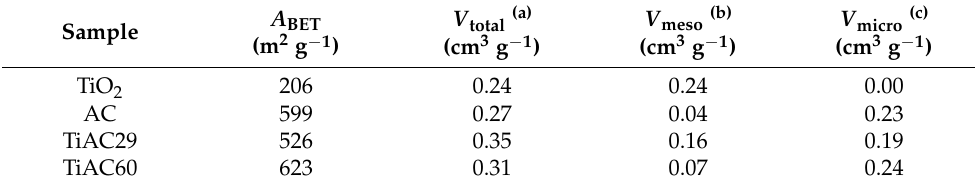
Table 2. Textural characteristics of the